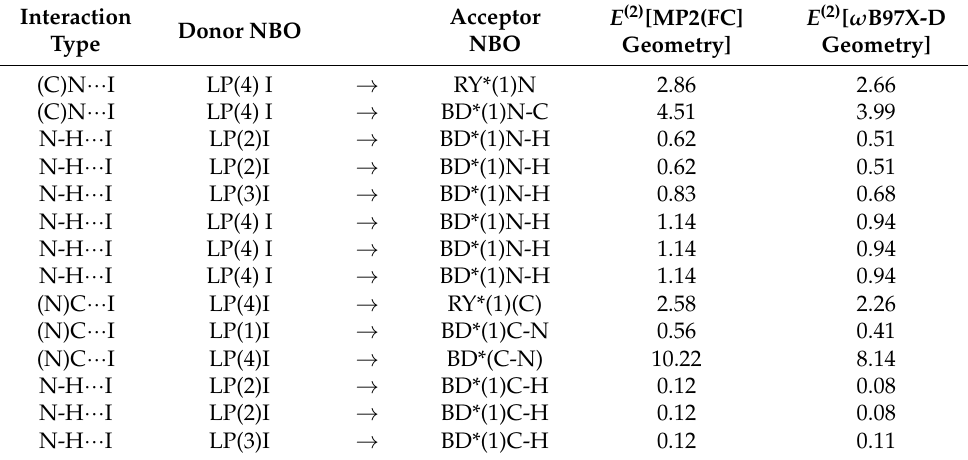
Table 3. RHF/6-311G* level second-order perturbative estimates of ‘donor- acceptor’ (bond-antibond) interaction energies, E (2) (in kcal mol − 1 ), in the NBO basis, obtained for H 3 C-H 3 N ··· I and H 3 N-H 3 C ··· I using their MP2(FC)/TZVPPD and ω B97X-D/TZVPPD level optimized geometries.